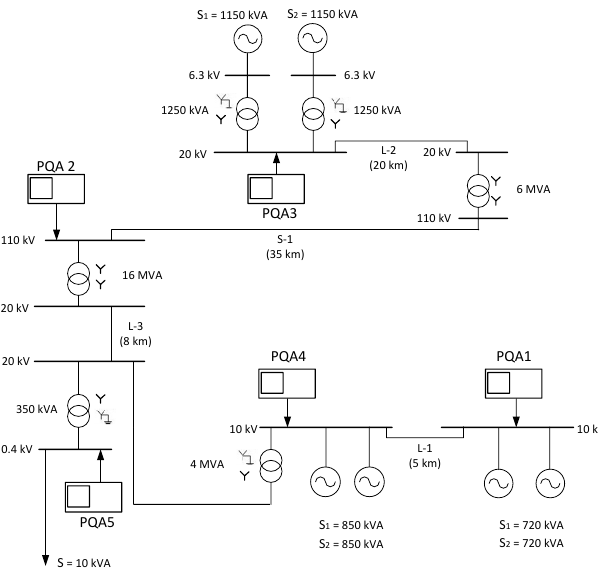
Fig. 2. Schematic of the supervised PQ monitoring system.